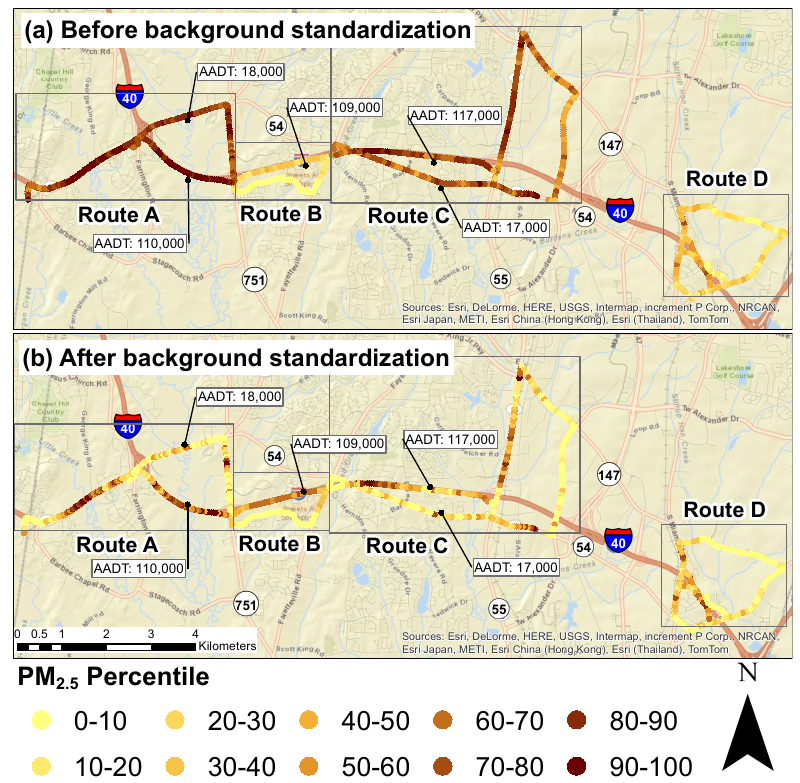
Figure 7. Spatial distribution of PM 2 . 5 before (a) and after (b) background standardization. Points represent median 50m values from eight sampling runs with each route measured on two days. Points are colored by PM 2 . 5 percentile. Table 4. Effect of temporal and spatial smoothing on pollutant Spearman correlation coefficients. Temporal smoothing Spatial smoothing Filtered raw data 5s 10s 10m 50m 100m N = 8386 N = 1801 N = 921 N = 529 N = 105 N = 52 NO 2 (ppb) and PM 2 . 5 (µgm − 3 ) 0.07 0.10 0.16